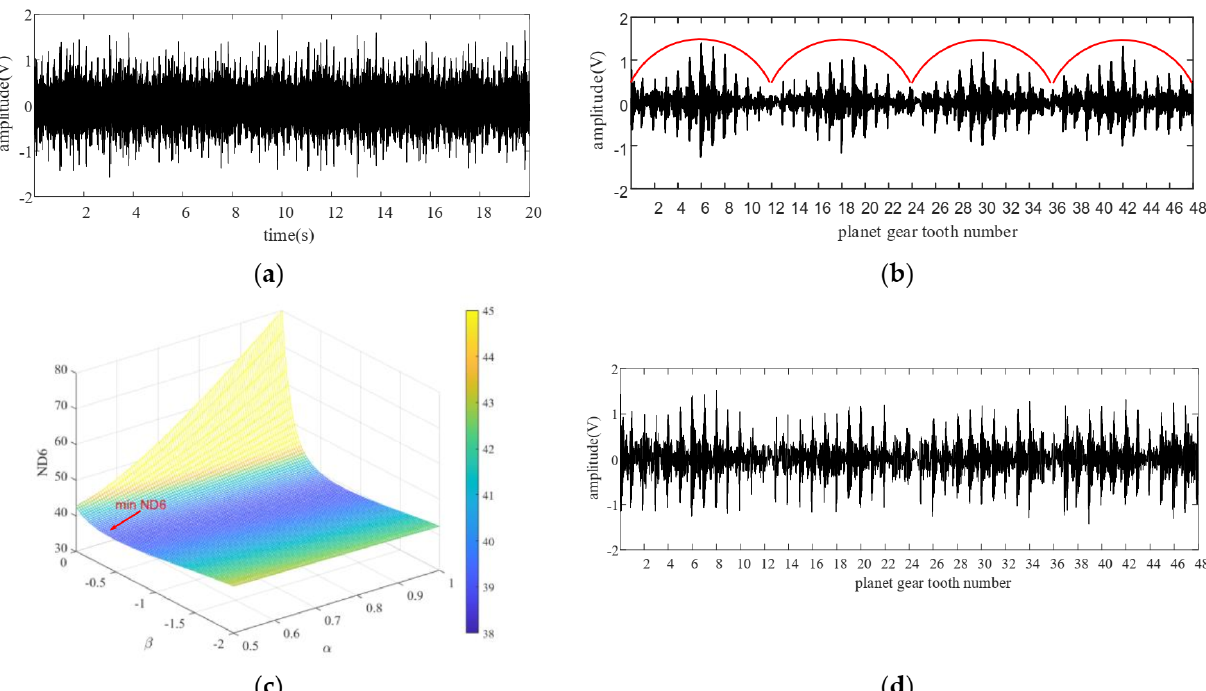
Figure 9. Baseline signal with 1200 rpm analysis results: ( a ) vibration signal, ( b ) multi-teeth VS waveform, ( c ) the ND6 with different value of α and β , and ( d ) the TVTF-VS